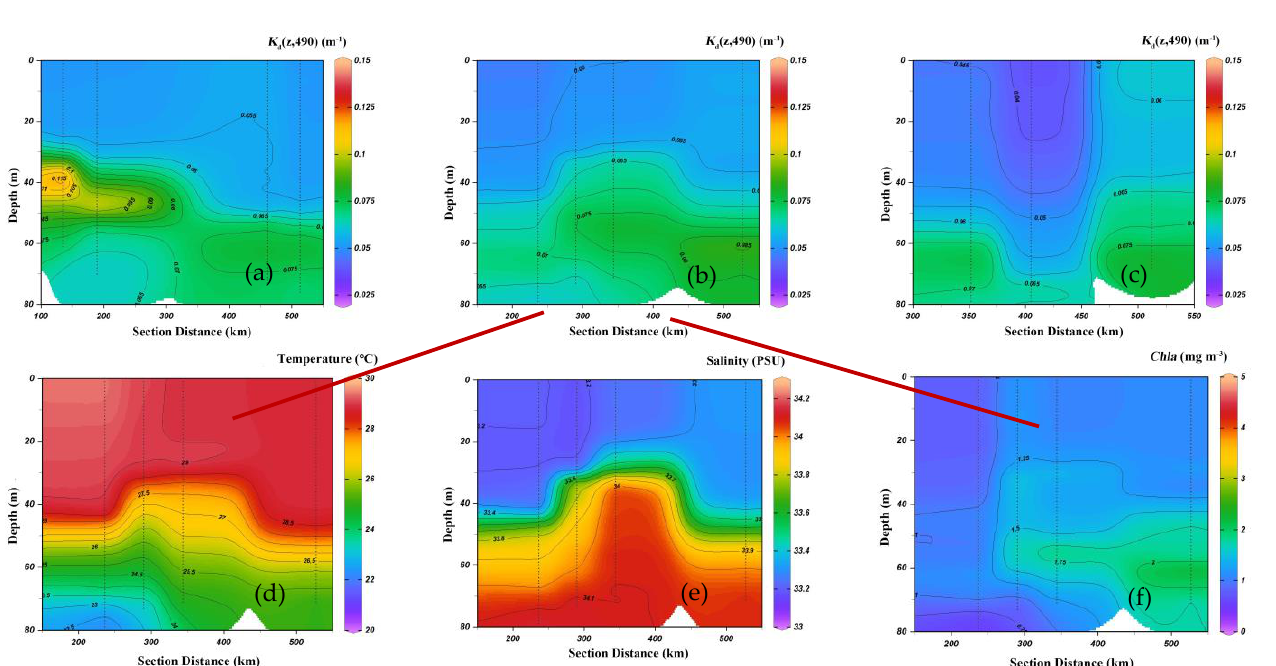
Figure 7. Vertical and horizontal distributions of K d ( z ,490 ) in the upwelling area of eastern Vietnam: ( a ) Section e, ( b ) section f, ( c ) section g, ( d ) temperature in section f, ( e ) salinity in section f, and ( f ) Chla in section f.